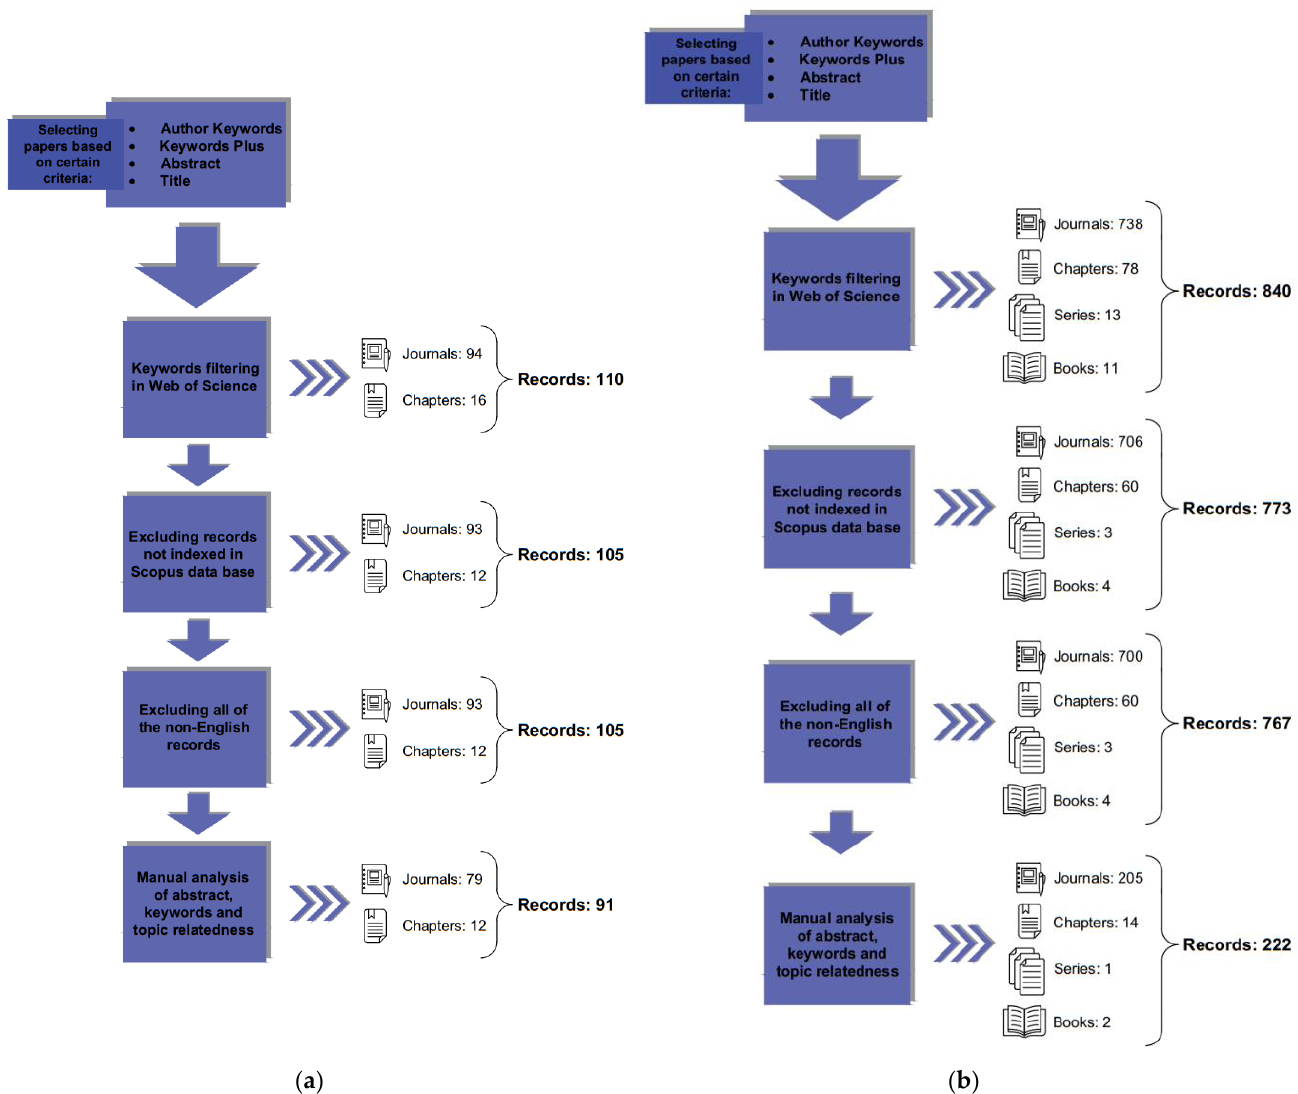
Figure 1. Indication of studies for bibliometric analysis: ( a ) greywater energy recovery domain; ( b ) greywater recycling domain.